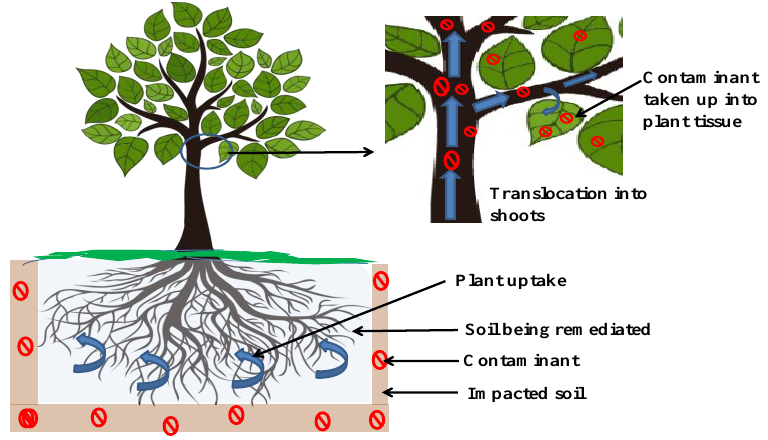
Figure 2. Mechanism of phytoextraction. Table 2. Sources of heavy metal contamination and metals’ adverse impacts on terrestrial and aquatic life systems.